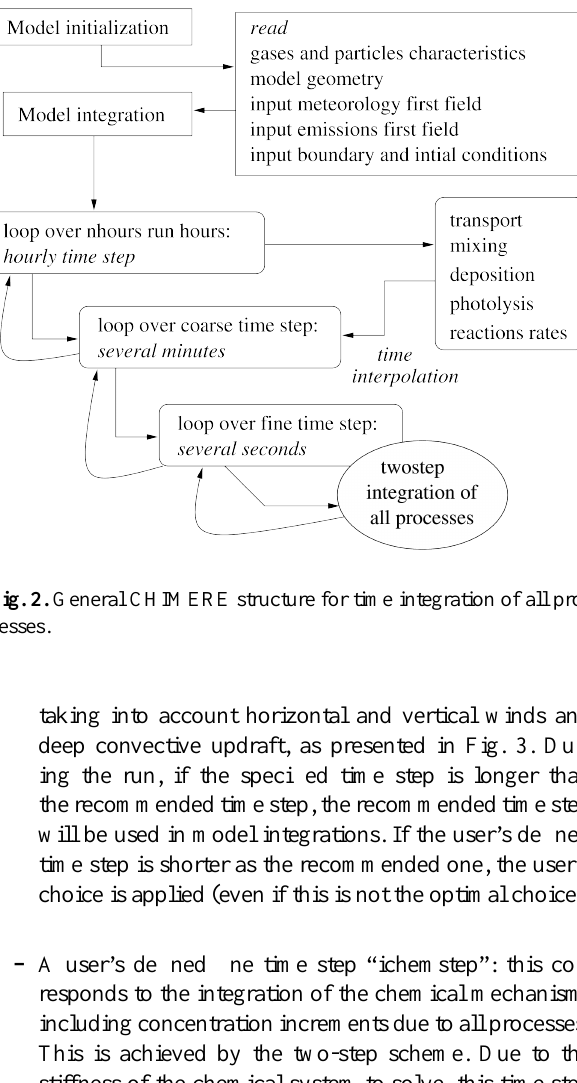
Fig. 3. Calculation of the number of integration steps per hour to respect the Courant-Friedrich-Levy (CFL) number over a complete 120 hours simulation. The CFL is estimated using three parame- ters: the mean wind speed | U | , the vertical wind speed in the envi- ronment w and the vertical velocity in the updraft in case of active deep convection.